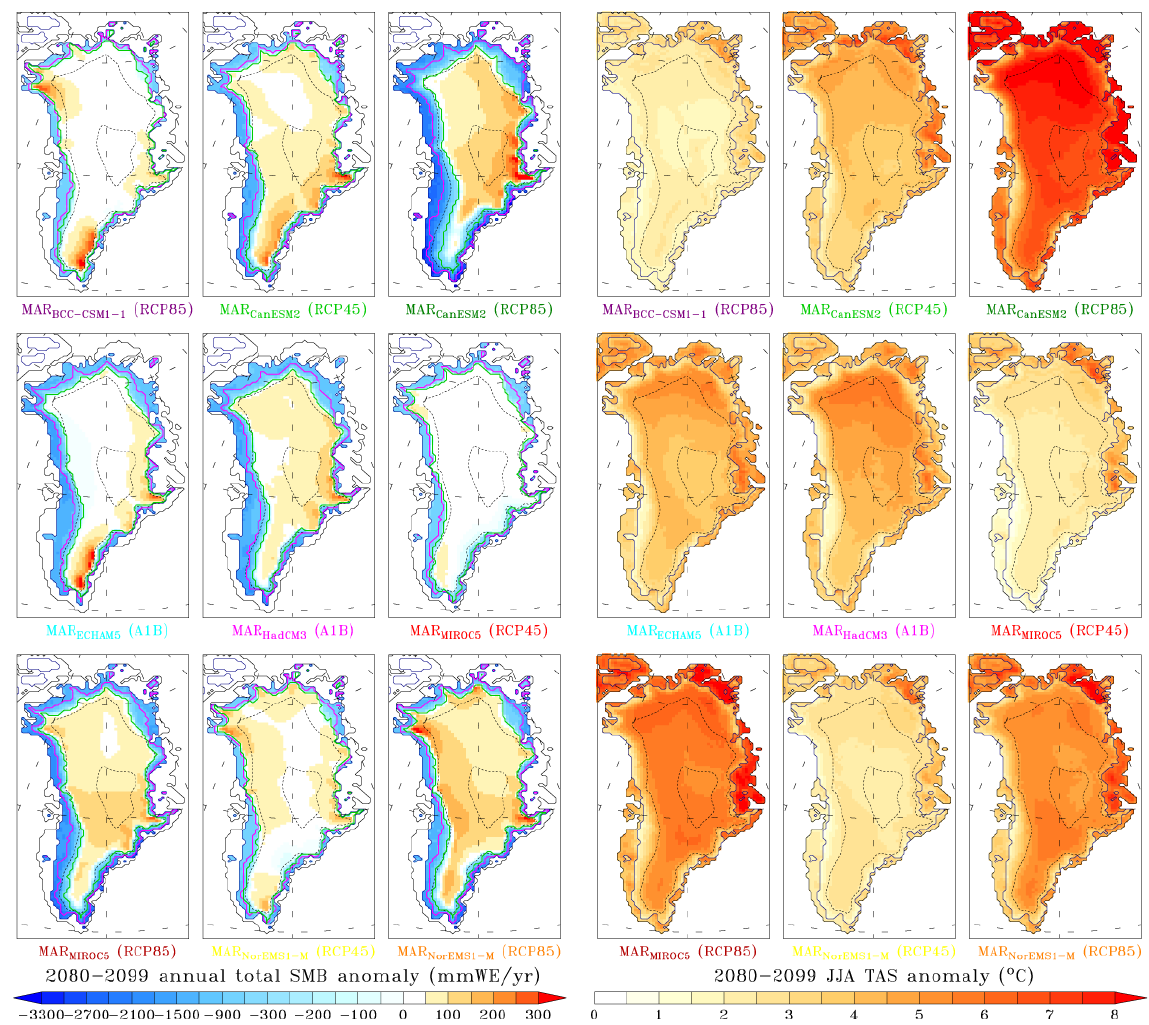
Fig. 5. Anomalies of the mean annual SMB over 2080–2099 with respect to 1980–1999. Units are mmWEyr − 1 . Finally, the ELA over 1980–1999 (resp. 2080–2099) is plotted in mauve (resp.